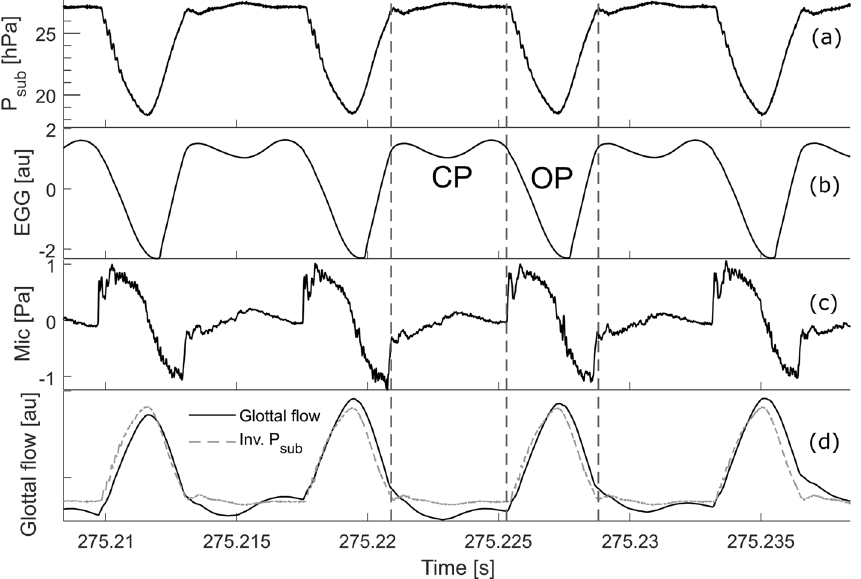
Figure 2. Signal waveforms for the excised larynx experiment in steady phonation, obtained using the anechoic subglottal tract. ( a ) Subglottal pressure; ( b ) EGG signal in arbitrary units [au]; ( c ) microphone signal (radiated sound) at 10 cm distance from the glottis; ( d ) glottal flow signal obtained by inverse filtering (black solid line) and inverted subglottal pressure (dashed gray line). The inverted subglottal pressure waveform in ( d ) was scaled to match the amplitude of the flow to observe the similarity of these waveforms. The closed phase (CP) and open phase (OP) were identified manually using both EGG and subglottal pressure